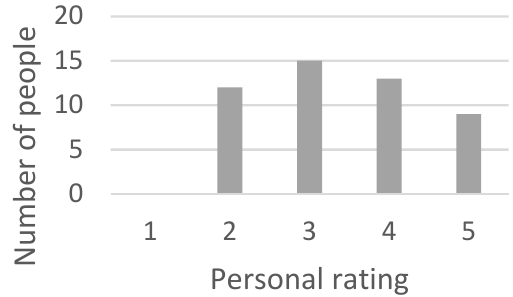
Figure A10. Rating of usefulness of the current information on the recycling scheme, first survey (49 individuals).